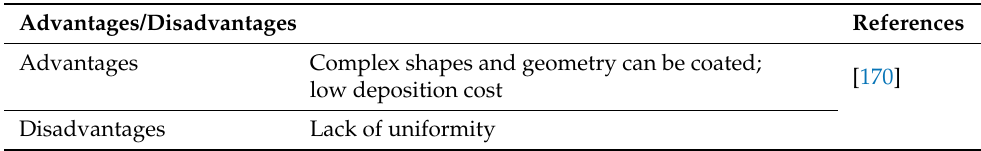
Table 9. Some of the significant advantages and disadvantages of electrophoretic deposition are mentioned in this table.